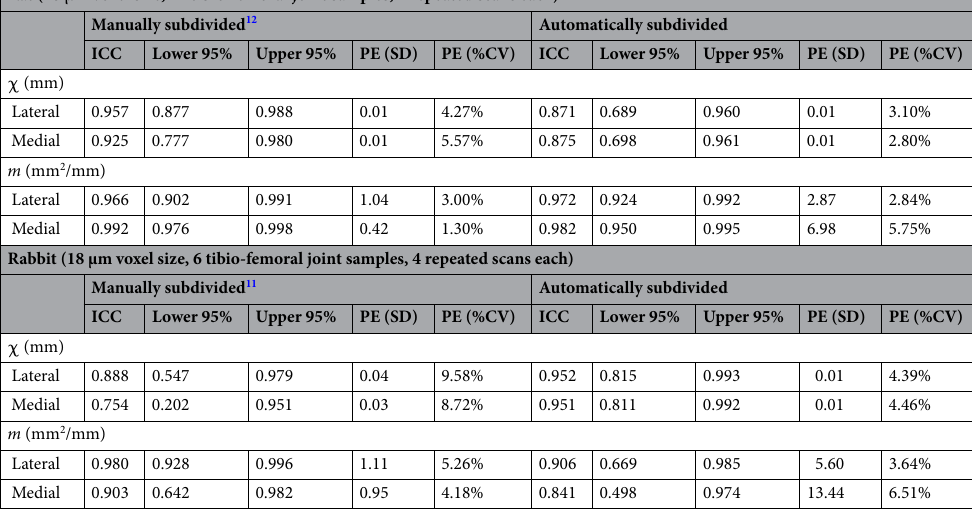
Table 2. Reproducibility of the rat and rabbit joint contact area under virtual loading in terms of intraclass correlation coefficient (ICC) and precision errors (PE) expressed in absolute and a percentage of the coefficient of variation of the repeated measure ( χ : distance travelled to first contact, m : rate at which contact area